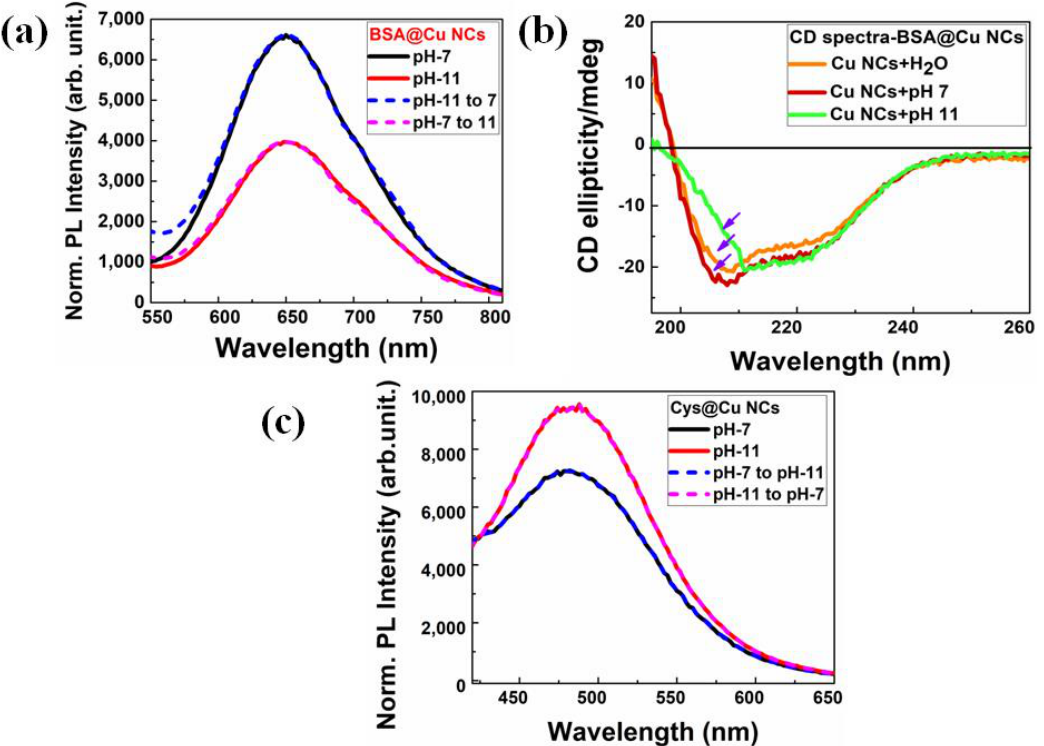
Figure 4. Measurement of pH reversibility on the optical characteristics of two different color-emitting Cu NCs. ( a ) Due to structural alterations in the protein, BSA-Cu NCs exhibited high emission behavior at neutral pH and weak emission intensity at pH 11. ( b ) CD spectra of BSA-Cu NCs revealed the secondary structural changes in BSA protein. The purple arrows indicate the structural changes in the protein. ( c ) Due to the availability of more thiol groups at higher pH 11, where emission decreased at the lower pH 7, single-amino-acid cysteine-mediated Cu NCs displayed unique behavior when compared to protein